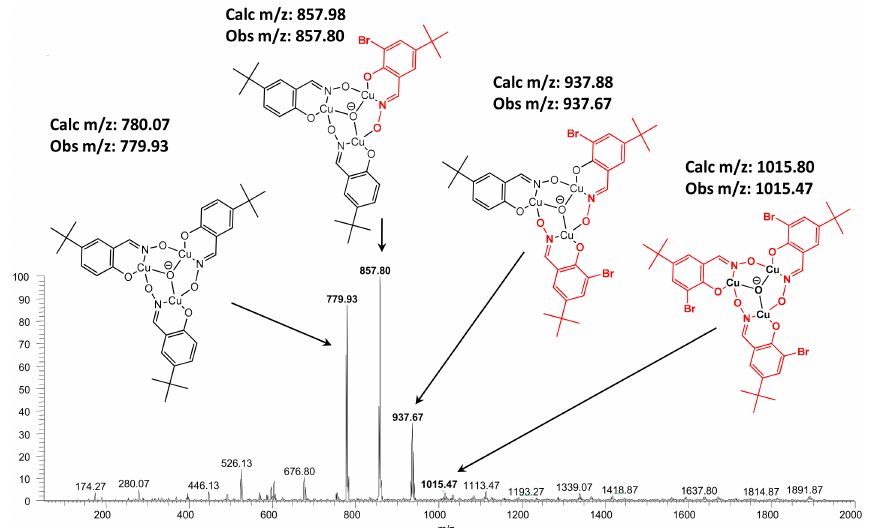
Figure 9. The mass spectrum obtained from a MeCN solution of Cu(II) acetate (50 µ M) and L 6 H 2 and L 8 H 2 (each 25 µ M). Proposed structures are inset with observed and calculated monoisotopic masses.